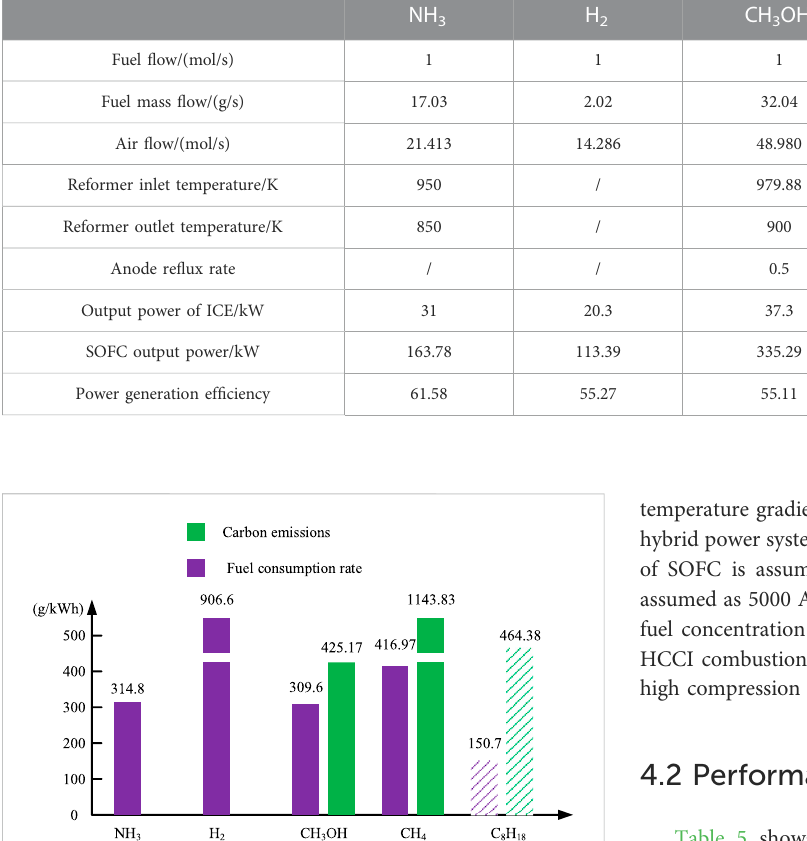
FIGURE 7 Performance of the SOFC/ICE fueled by different